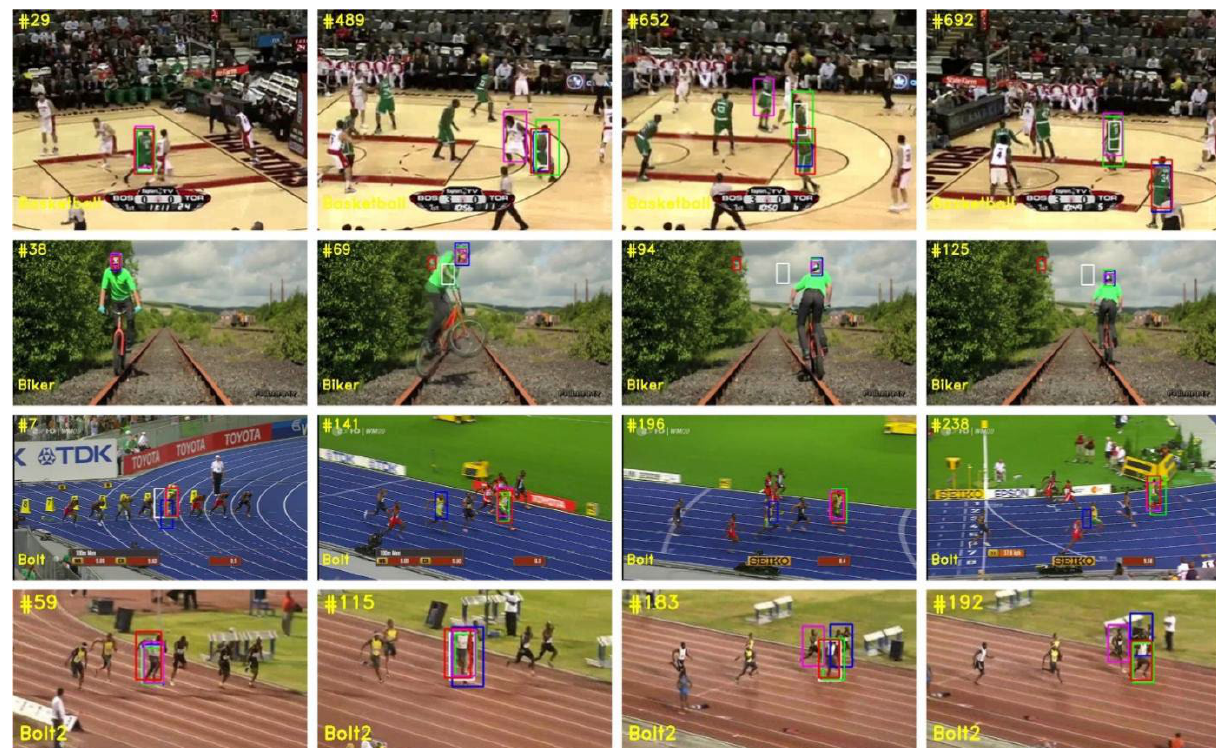
Figure 12. Qualitative results for some typical challenging scenarios.